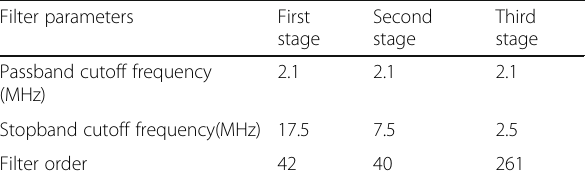
Table 1 Parameters for each stage of the filter before the